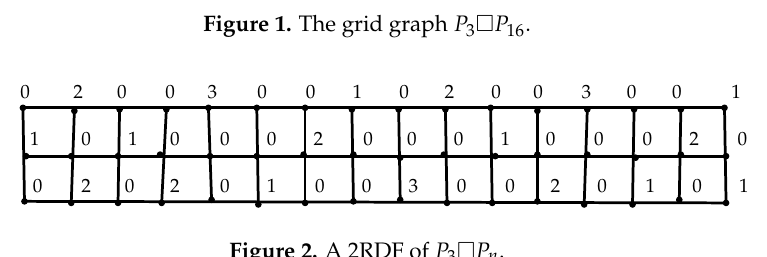
Figure 2. A 2RDF of P 3 (cid:3) P n